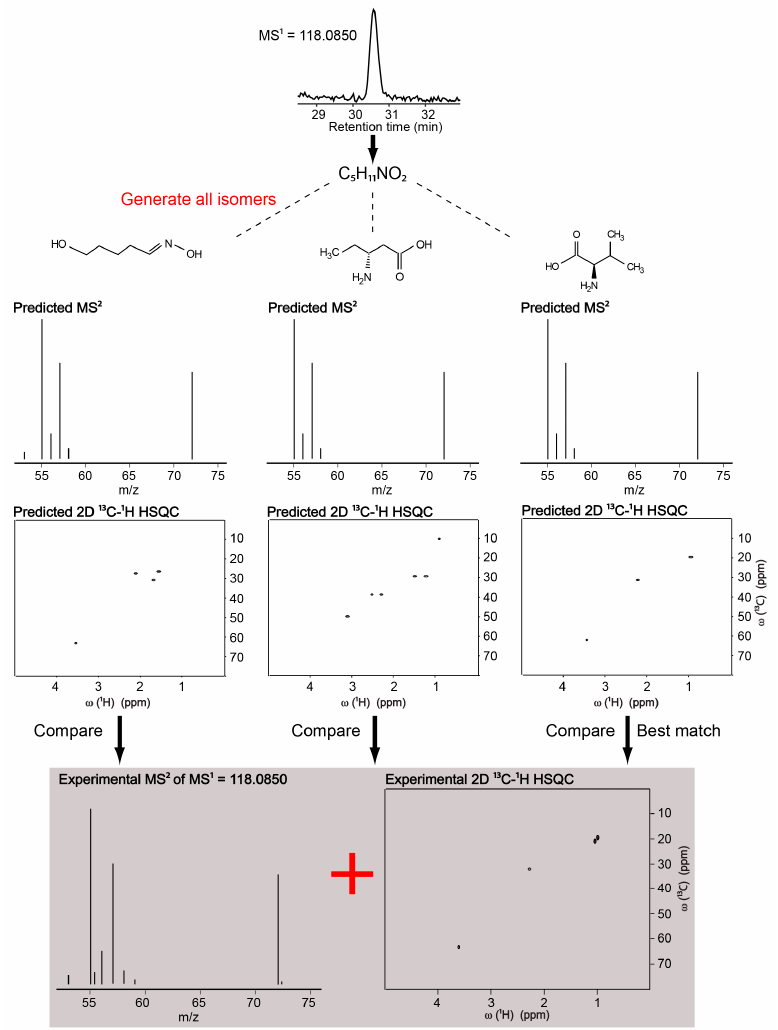
Figure 1. Workflow of the NMR/MS 2 approach on a single metabolite (valine) in the NMR spectrum.